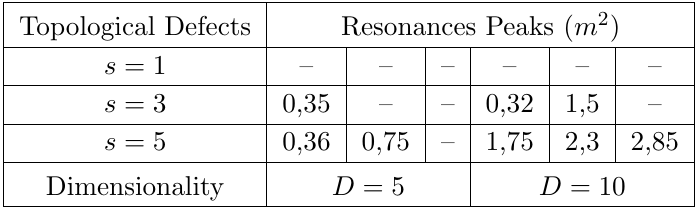
Table 1 . Peaks of resonances for massive left handed fermions (odd dimension) or Dirac fermions (even dimensions choosing (cid:24) n (cid:0) ( x )) for (cid:21) = 0 ; 4.